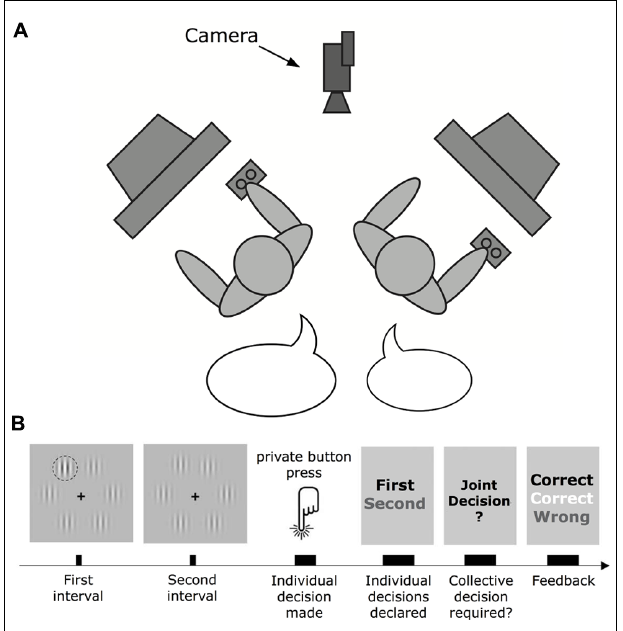
FIGURE 1 | Experimental setup (adopted with permission from Fusaroli etal., 2012). (A) The experimental setup. (B) Schematic illustration of a typical